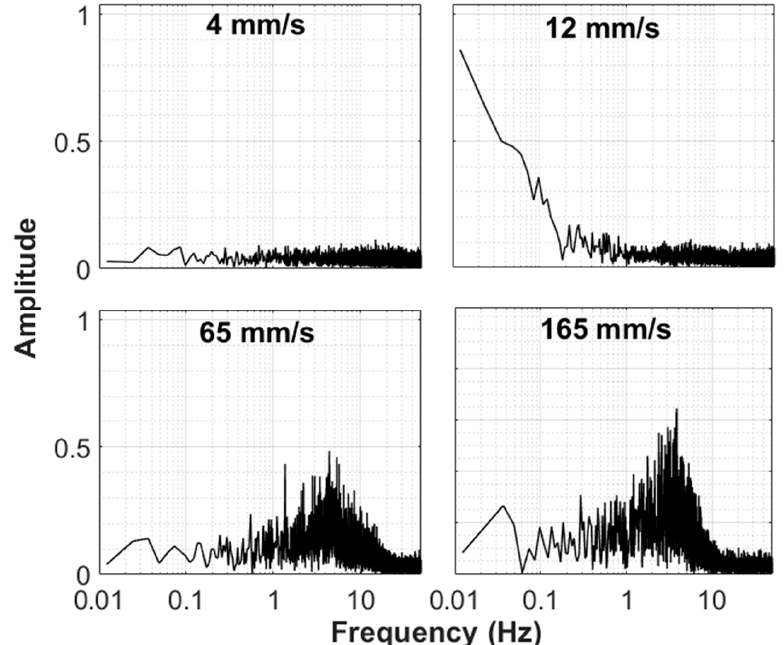
Figure 16. Frequency response of overall bed dynamics at different velocities of fluidization cycle for unassisted fluidization.